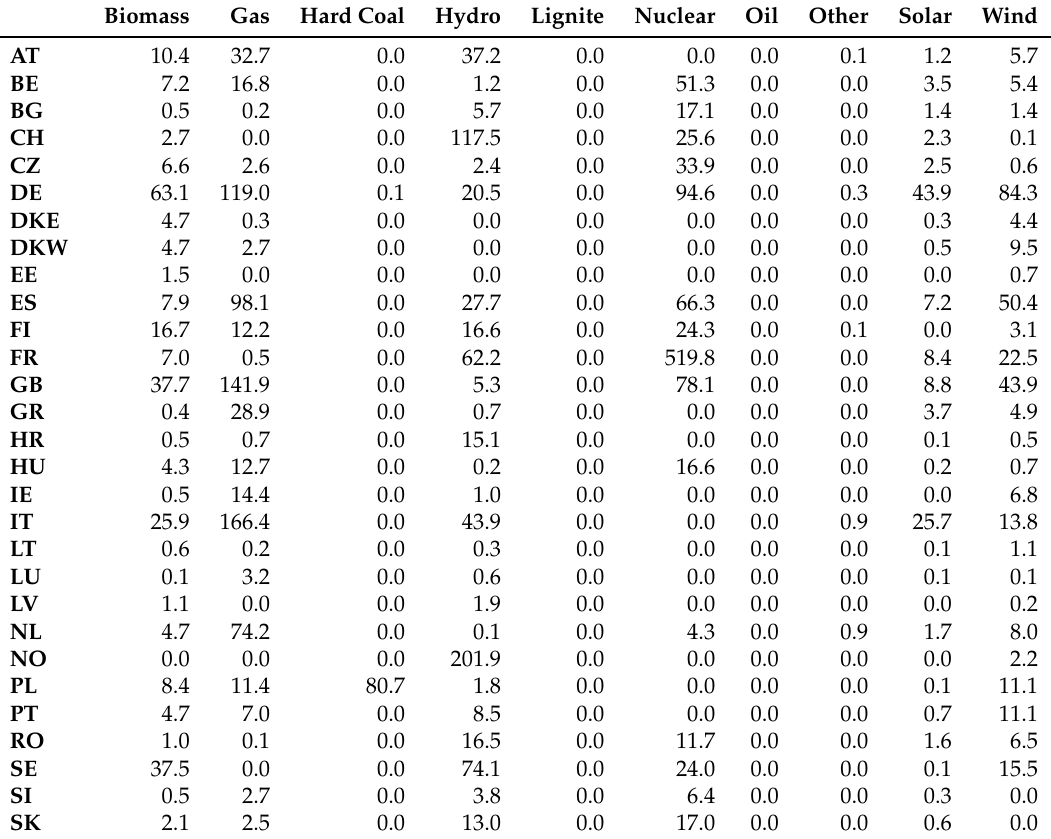
Table A4. Electricity generation [TWh/a]—EmiCap.